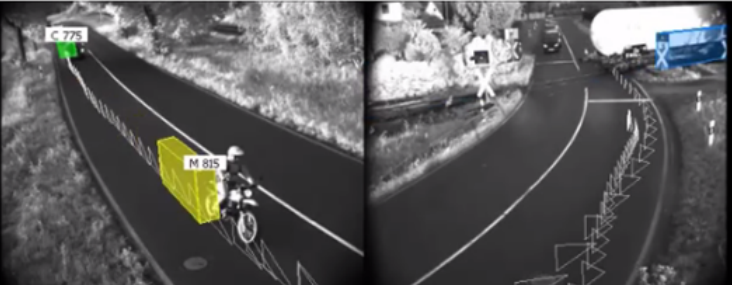
Figure 3: Visualization of a railway crossing traffic scene with augmented object information.